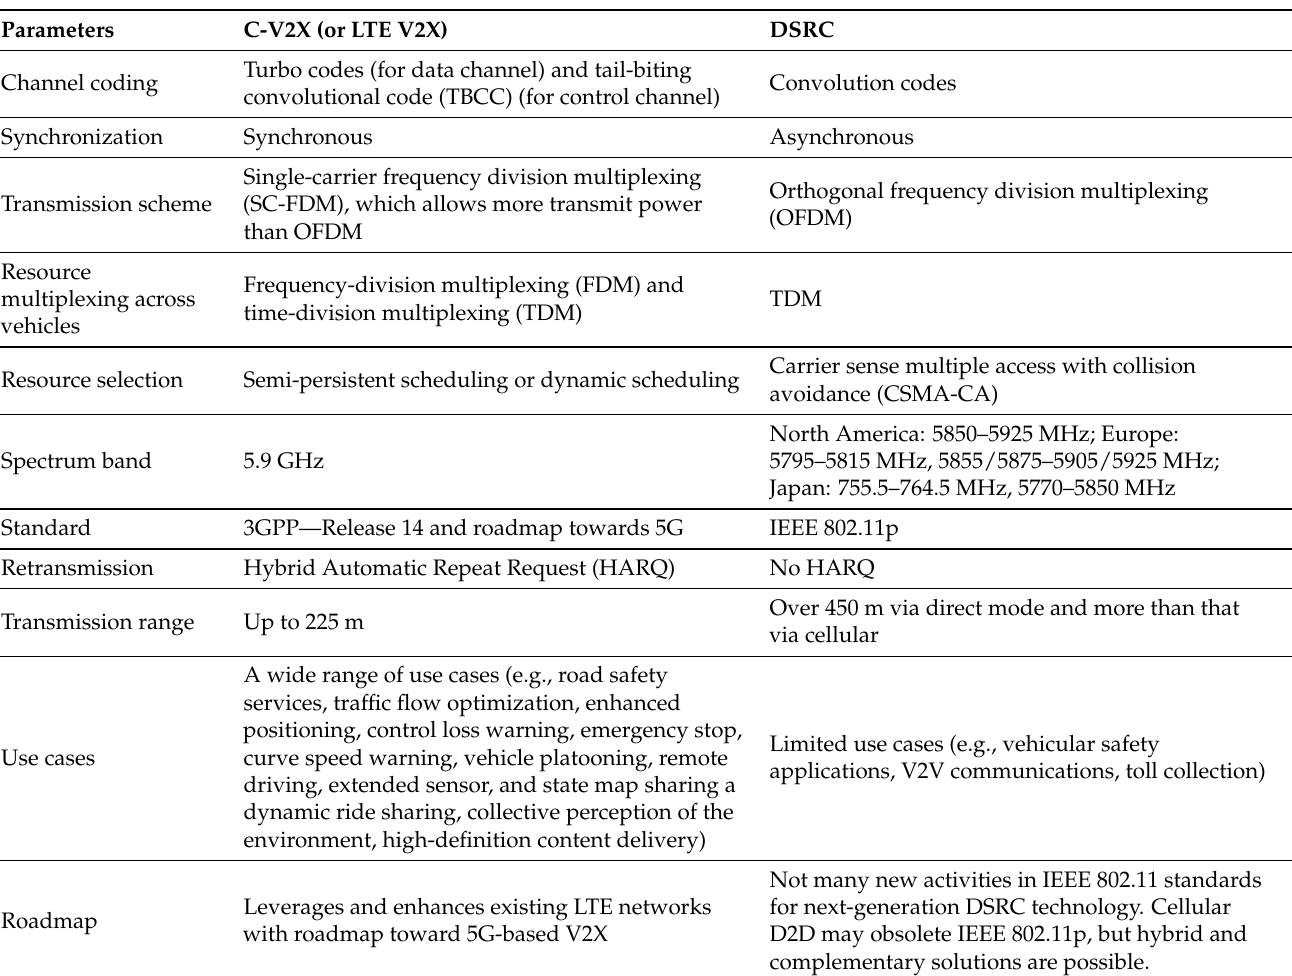
Table 1. Comparison of emerging cellular V2X (C-V2X) communications and conventional dedicated short-range communications